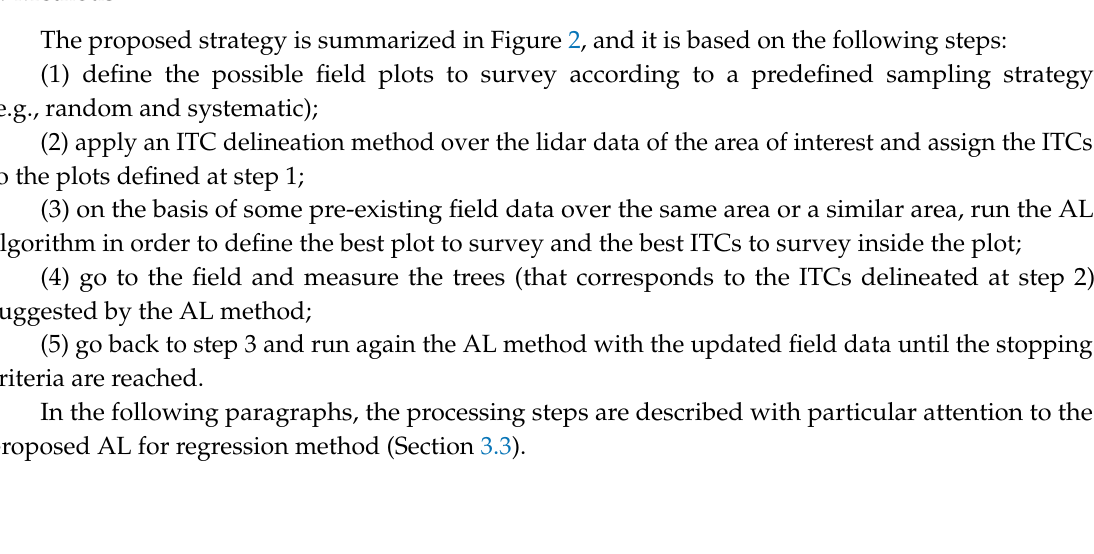
Figure 1. Location of the two study areas: ( A ) Hadeland and ( B ) Våler. In panels A and B the field plots locations of Hadeland ( A ) and Våler ( B ) are shown. In panels C and D two examples of field plots with the tree positions in Hadeland ( C ) and Våler ( D ).